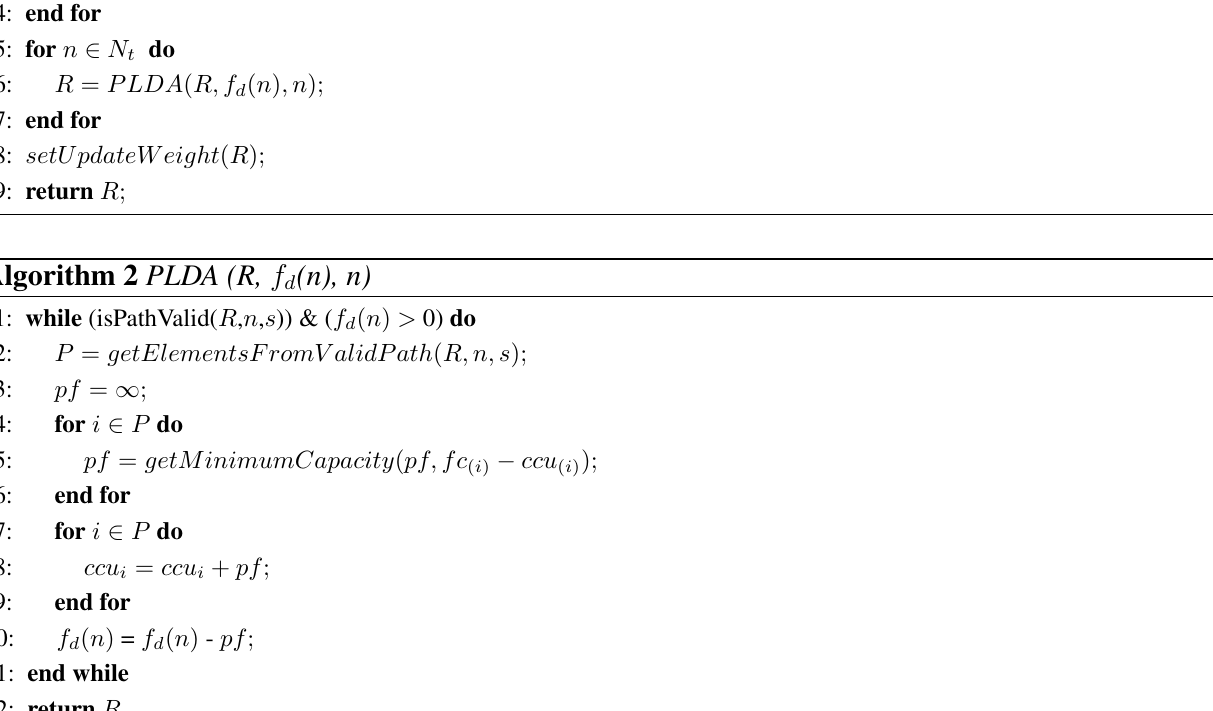
Algorithm 1 Initialize Power Load Distribution Algorithm (PLDA; G)